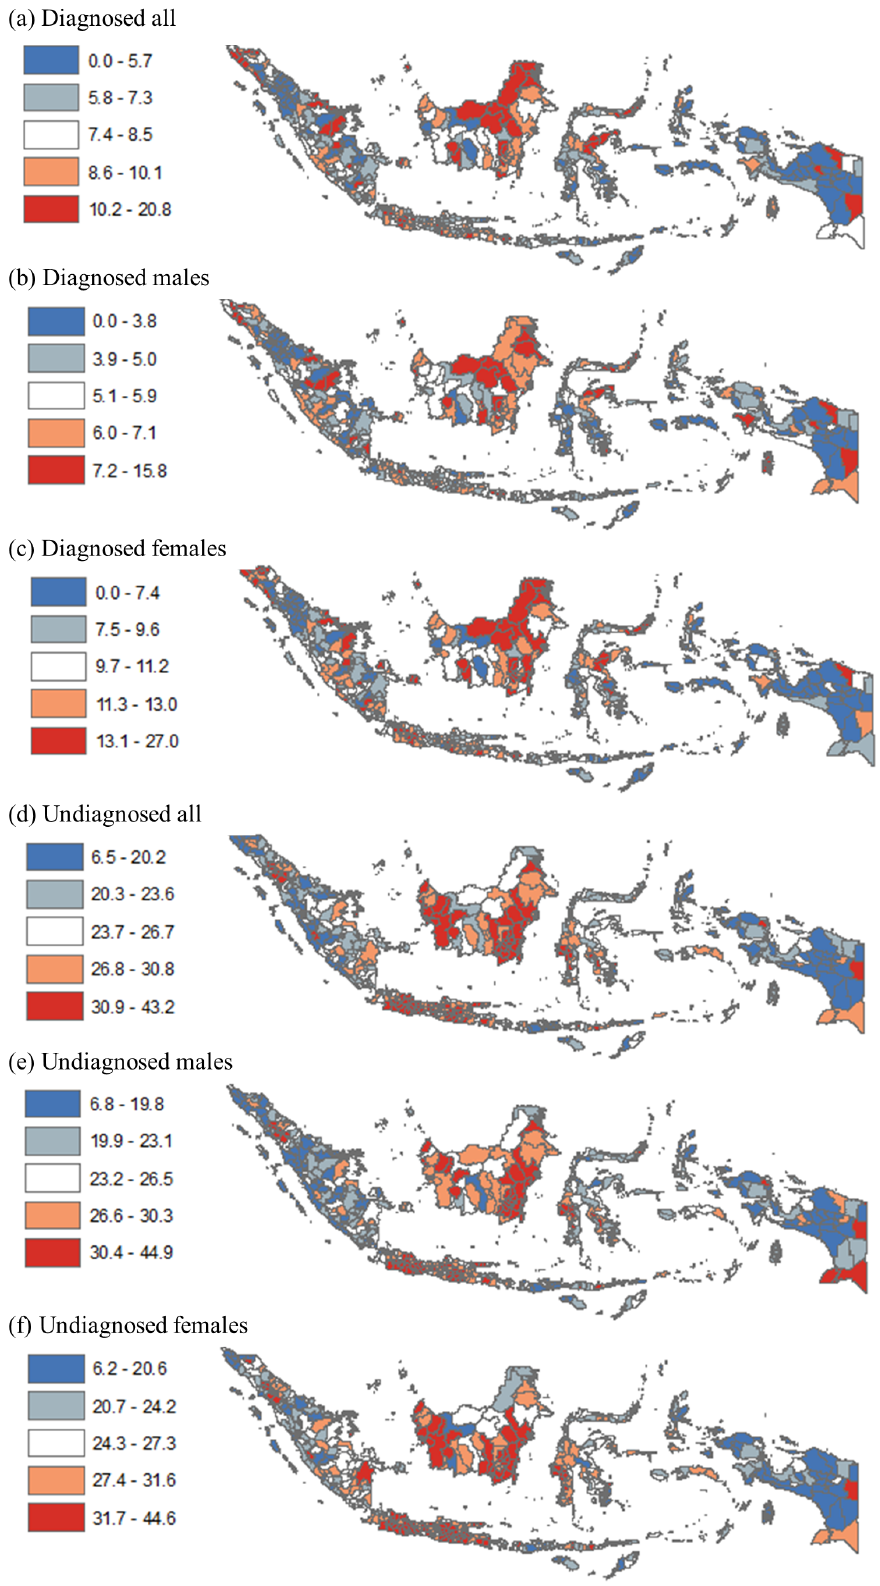
Figure 2. Disparity in diagnosed and undiagnosed hypertension among adults (18+ years) by district in Indonesia, 2018. Note: Numbers show prevalence of diagnosed and undiagnosed hypertension among all adults, males, and